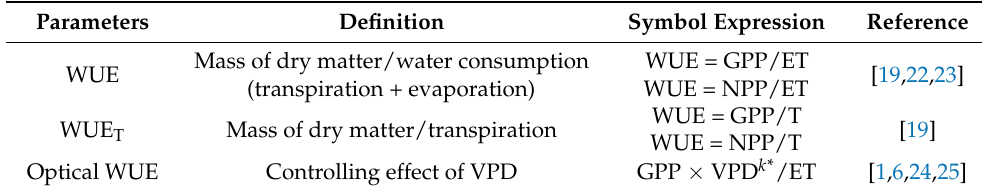
Table 1. Description of WUE-related ecological parameters.